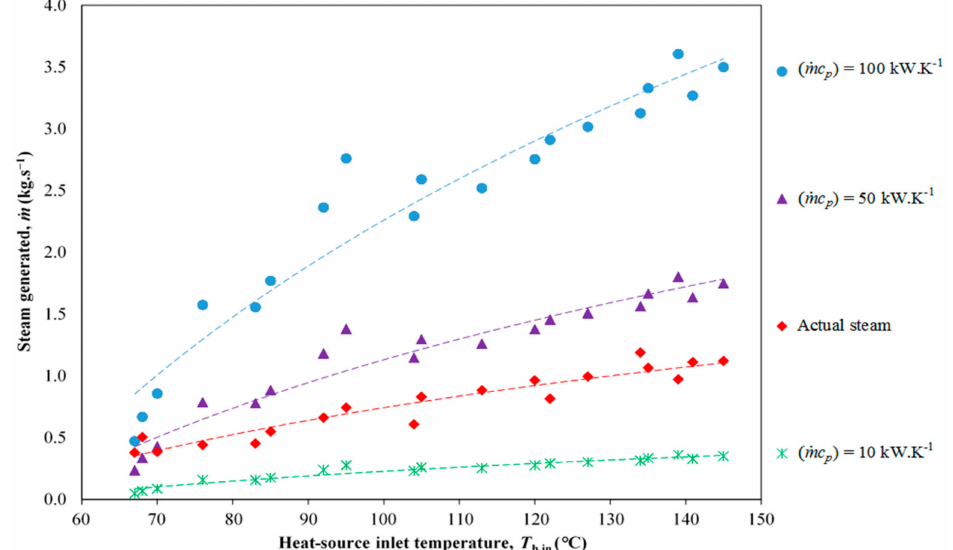
Figure 10. LP steam (150 ◦ C) generated by MVC heat pumps when utilizing the thermal energy available in the streams listed in Table 5 as a function of the heat-source inlet temperature (“actual steam” points and curve). Also shown is the LP steam generated when utilizing streams with the same . mc p ) = 10, 50, and 100 kW.K − 1 temperature di ff erences as in Table 5 but with heat capacity rates (